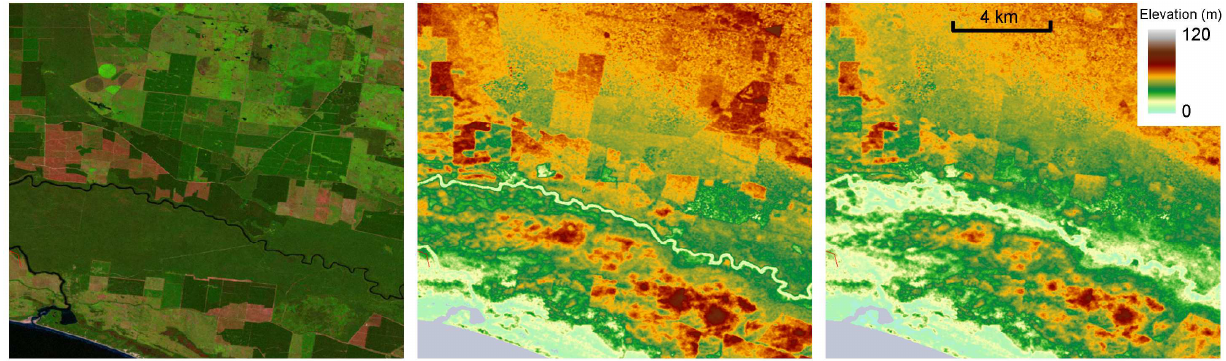
Figure 3. Landsat image (left), DSM (centre) and DEM (right) near Nelson, Victoria, 141.08°E